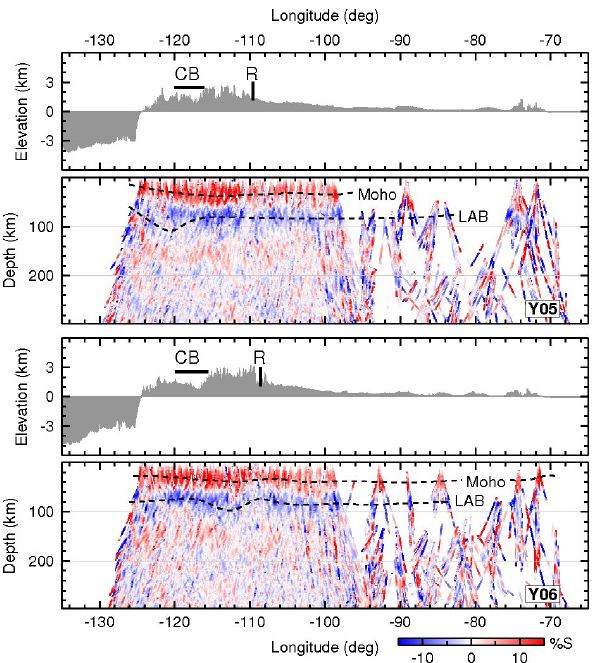
Fig. 7. Migrated S receiver functions along profiles Y09 and Y10 as in Fig. Migrated S receiver functions along profiles Y09 and Y10 as in Fig. 3.